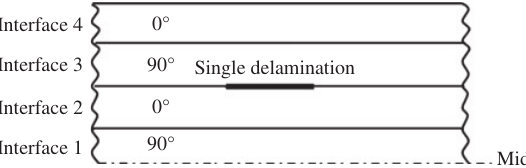
Figure 3 Interface locations of the delaminations for a [0/90] graphite/epoxy composite laminate [9]